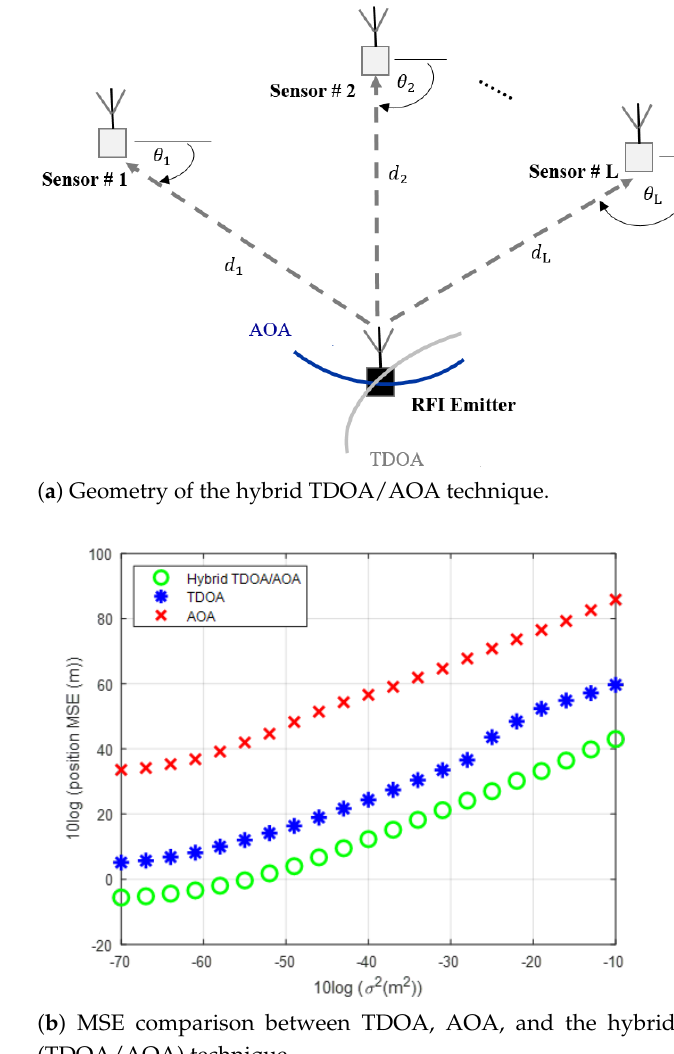
Figure 8. The geometry and performance verification of the hybrid TDOA/AOA technique. Individ- ual comparisons of the performance scenario of the hybrid TDOA/AOA technique with TDOA and AOA techniques was the main object in this scenario. Authors’ own